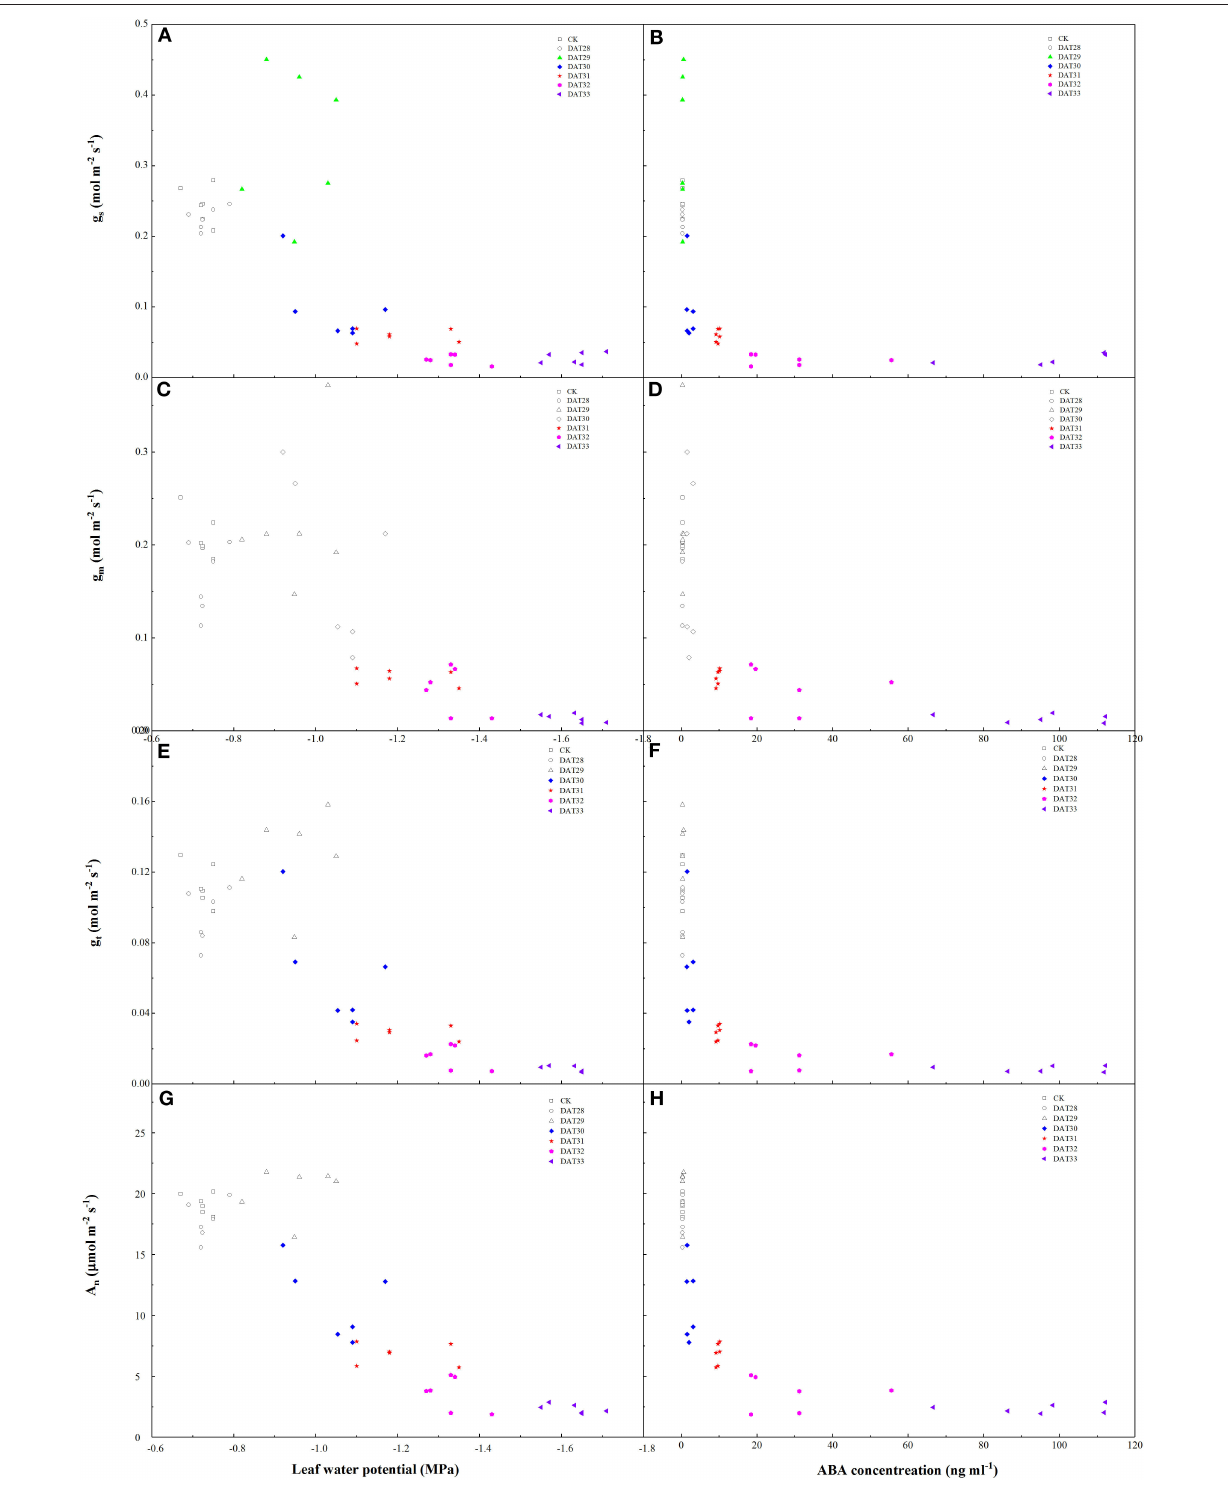
Frontiers in Plant Science |